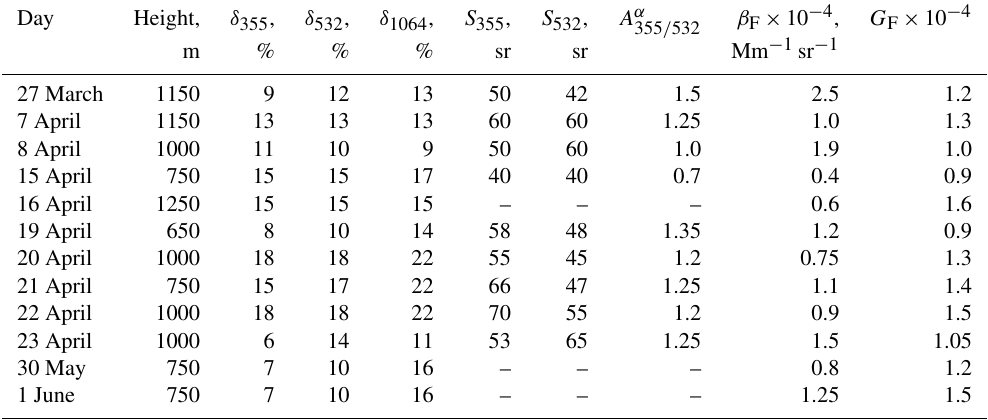
Table 1. Lidar-measured aerosol parameters, such as particle depolarization ratios ( δ 355 , δ 532 , δ 1064 ), lidar ratios ( S 355 ,S 532 ), extinction Ångström exponent ( A α ), fluorescence backscattering coefficient ( β F ) and fluorescence capacity ( G F ), for several days during the 355 / 532 March–June 2020 period when the contribution of pollen to the total particle backscattering could be